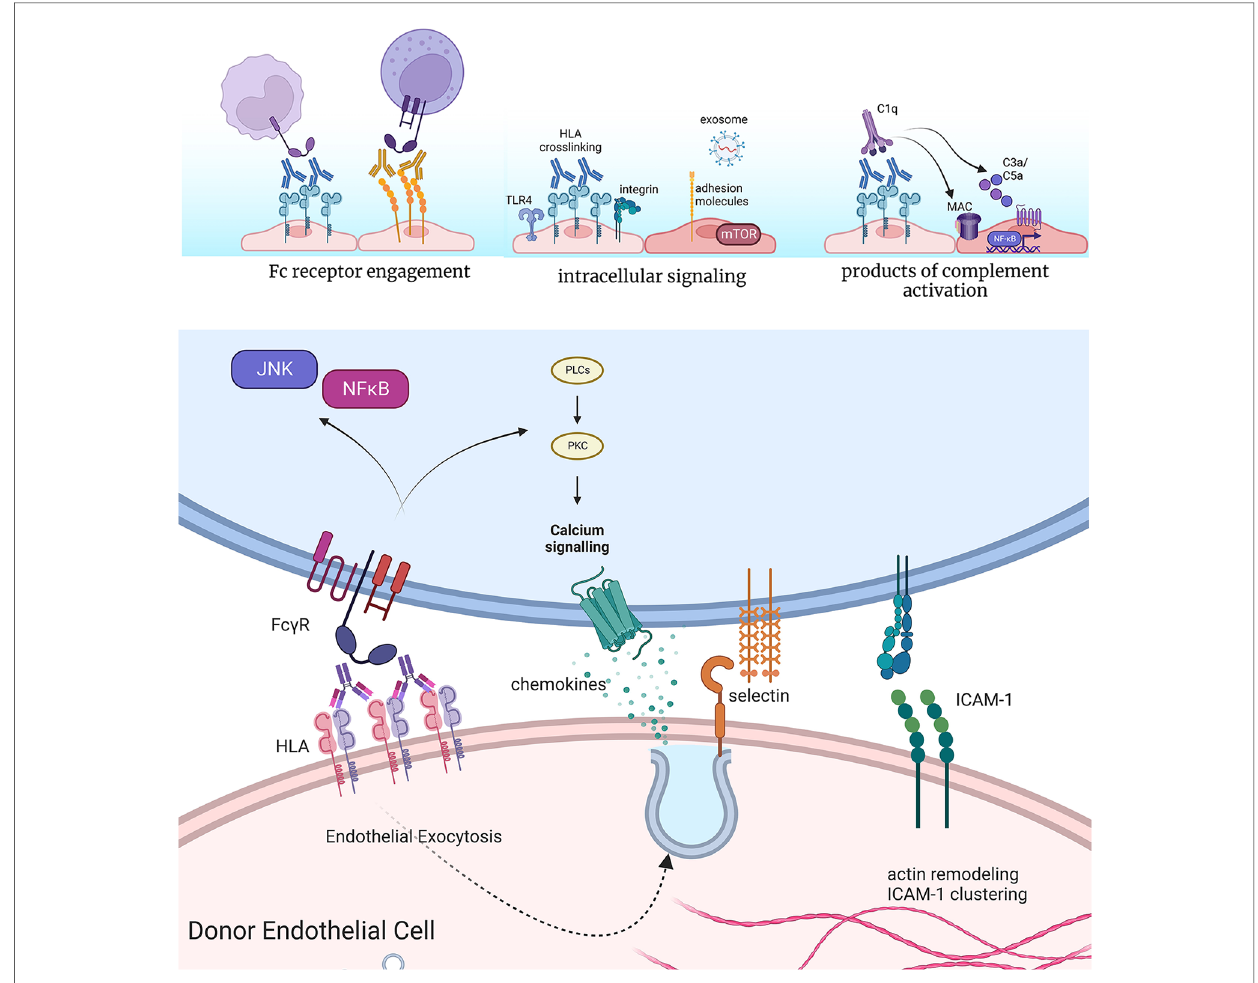
FIGURE 2 Effects of anti-HLA antibodies on acute in fl ammatory phenotypes of endothelium. Antibodies bound to the surface of endothelial cells can engage Fc gamma receptors on NK cells, neutrophils, and monocytes to enhance their adhesion and activation. Crosslinking of HLA by antibodies causes complex formation with TLR4 and integrin molecules at the cell surface of endothelium, which promotes intracellular signaling. This results in increased activation of pro-growth and survival signaling, predominantly through mTOR, as well as expression of adhesion molecules and release of exosomes. Finally, high levels of HLA antibodies can activate the classical complement cascade, producing split products C3a and C5a, which in turn can act on endothelial cells through their G protein coupled receptors for these molecules. In cases of extensive complement activation, deposition of the membrane attack complex (MAC) causes intracellular activation of NF κ B, promoting in fl ammatory gene expression. Endothelial cells rapidly exocytose Weibel-palade body vesicles to externalize P-selectin, through which neutrophils, platelets and monocytes can tether. Cytoskeletal remodeling also promotes clustering of pre- formed ICAM-1 molecules, which supports tethering and fi rm adhesion of adhering leukocytes. Concurrent engagement of Fc receptors further enhances the strength of the adhesion. Made in biorender